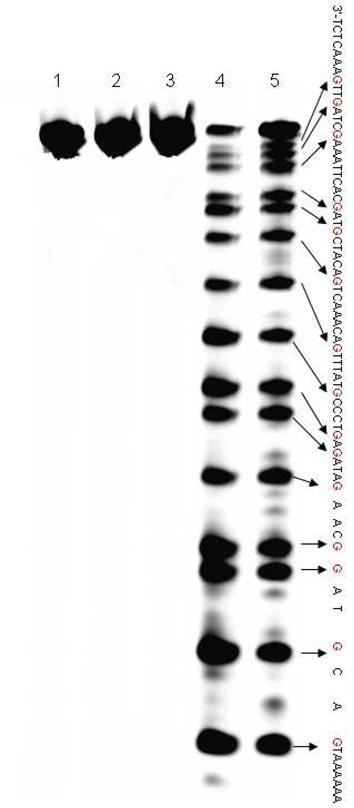
Polyacrylamide gel electrophoresis analysis of 76mer-DNA. The ODN (20 pmol) was oxidized by 20 mM K2WO4 and 200 mM H2O2 for 5 min, and further treated with hot piperidine at 90°C for 30 min. Lane 1: ODN alone; lane 2: ODN with 20 mM K2WO4; lane 3: ODN with 200 mM H2O2; lane 4: ODN with 20 mM K2WO4 and 200 mM H2O2; lane 5: G-ladder (DMS treated).